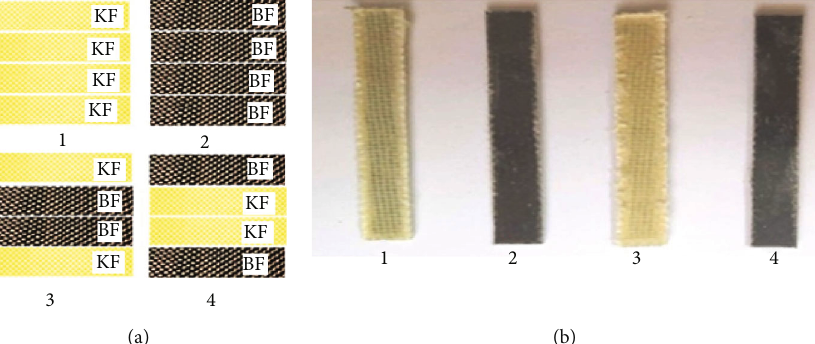
Figure 3: Epoxy hybrid composite. (a) Di ff erent stacking sequences of KF/BF on epoxy composite. (b) Developed hybrid composite